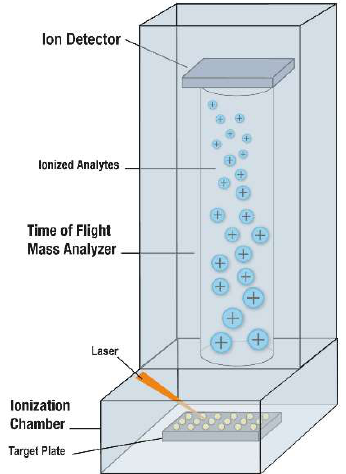
Figure 2. Mass spectrometer used for MALDI-ToF MS [1,3]. The MALDI-ToF MS plate is placed into the chamber of the instrument. Each spot to be analyzed is shot by a laser, resulting in desorption and ionization of bacterial or fungal and matrix molecules from the target plate. The cloud of ionized molecules is accelerated into the time-of-flight mass analyzer, toward a detector. Lighter molecules travel quicker, followed by progressively heavier ones. A mass spectrum is produced; it denotes the number of ions hitting the detector with time. Separation is by mass-to-charge ratio; because charge is typically single for this application, separation is by molecular weight. Used with permission of the